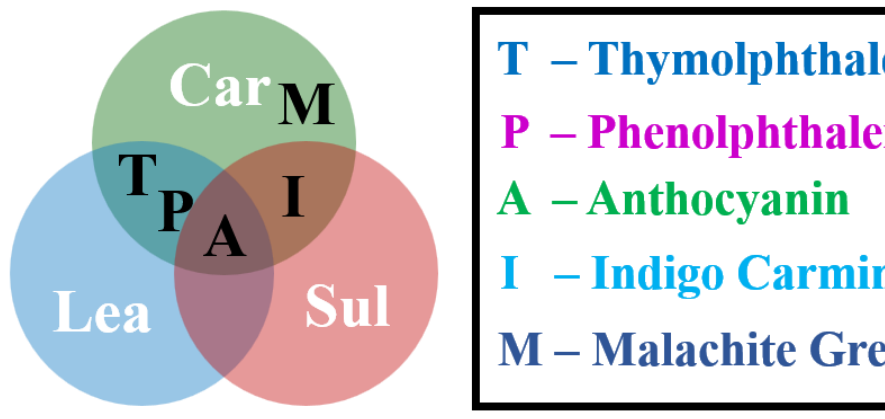
Figure 11. Suitable circumstances for each pH indicator.